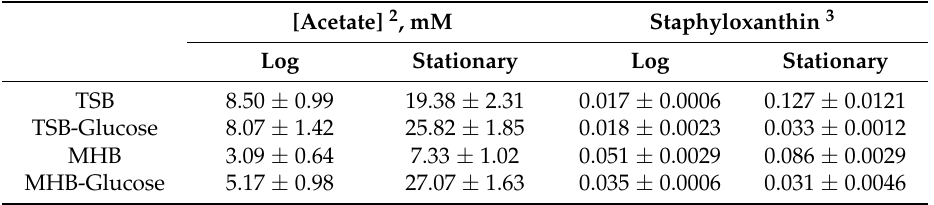
Table 8. Medium acetate 1 concentration and staphyloxanthin production in S. aureus strain Pig1. [Acetate] 2 , mM Stationary